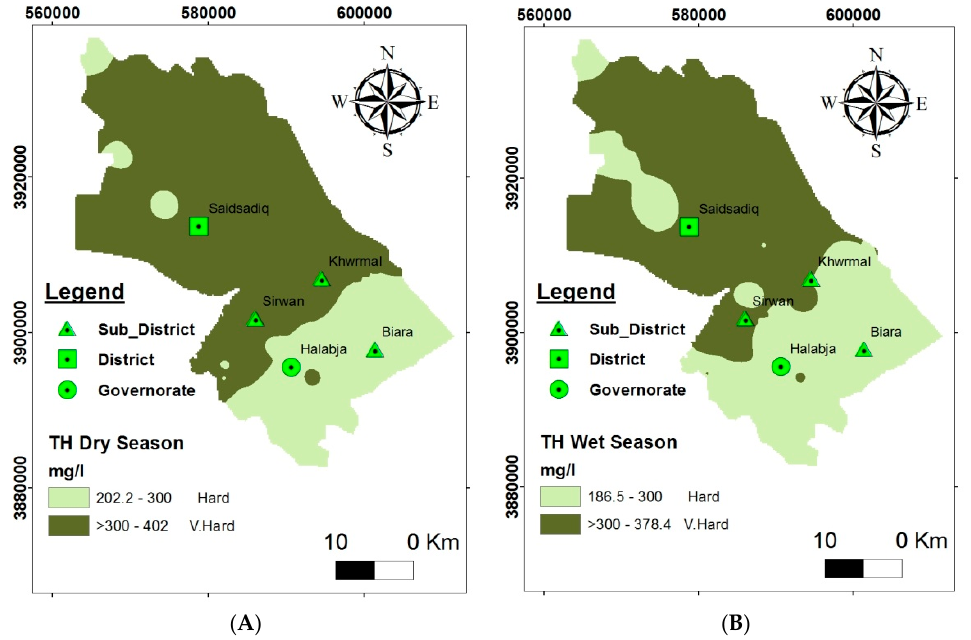
Figure 9. Groundwater suitability for domestic purposes according to the spatial distribution of TH: ( A ) dry season and ( B ) wet